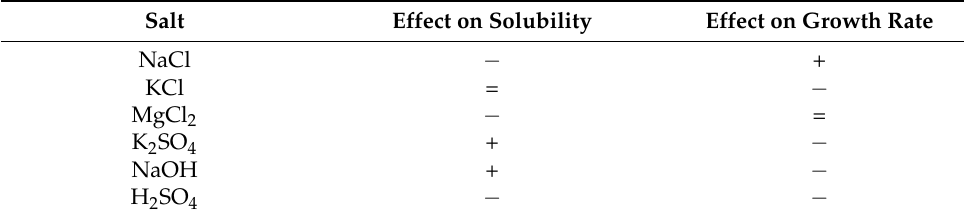
Table 4. Influence of other compounds on the solubility of epsomite, adapted from [25]. Salt Effect on Solubility Effect on Growth Rate NaCl − + KCl = − MgCl 2 − = K 2 SO 4 + − NaOH + − H 2 SO 4 −